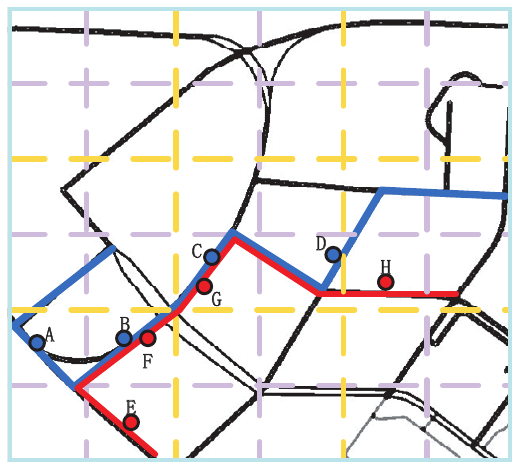
Figure 12. Illustration of Uniqueness Judgement. The blue and red lines are trajectories of two taxis with a timeline from 10:00